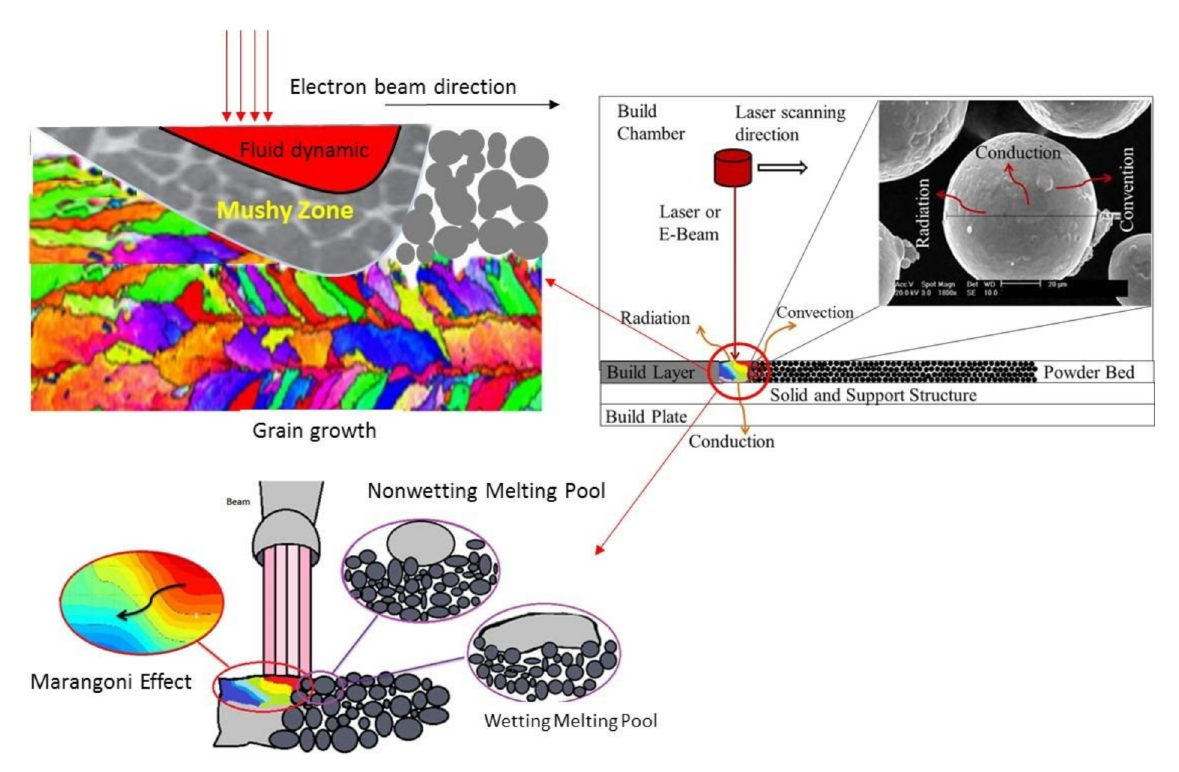
Figure 1. Physical phenomenon occurring during powder bed melting process of metallic